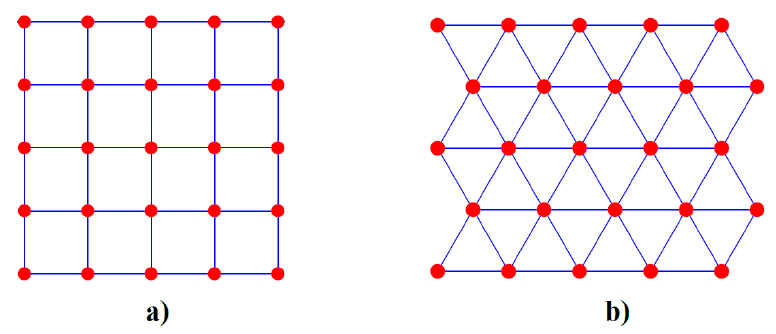
Figure 6. Typical SOM topologies: a rectangular output grid ( a ) and a hexagonal output grid ( b ).